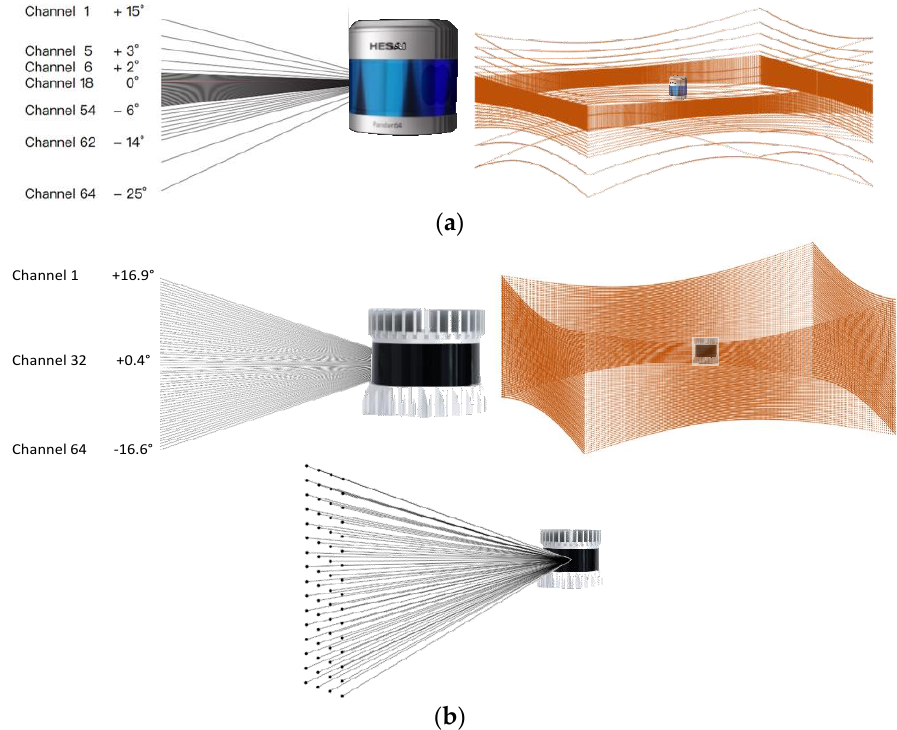
Figure 2. Scanning patterns of the two Lidar types. ( a ) Pandar64 Lidar. ( b ) OS-1-64